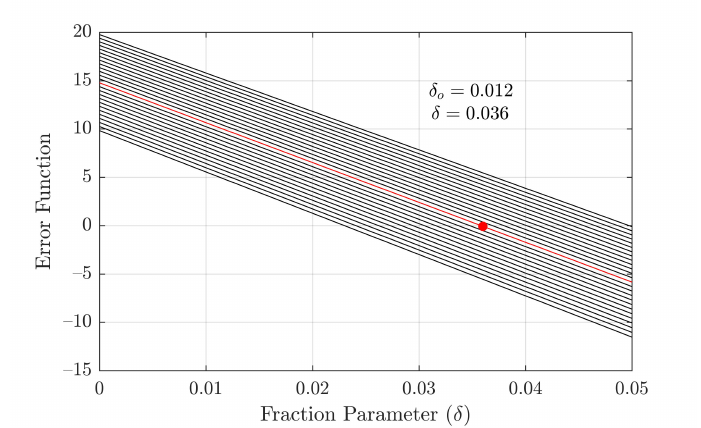
Figure 8. Plot of error function versus fraction parameter δ .